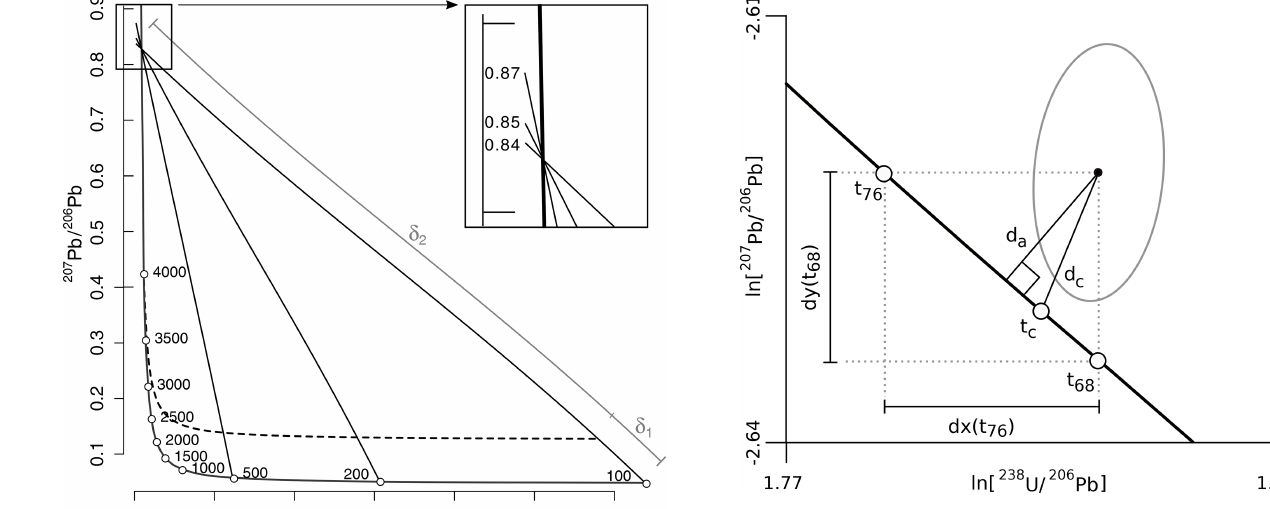
Figure 6. Illustration of the two log ratio distance definitions of discordance. d a is the perpendicular Aitchison distance from the measured log ratio to the concordia line. d c is the Aitchison dis- tance measured along a line connecting the measured value and the concordia